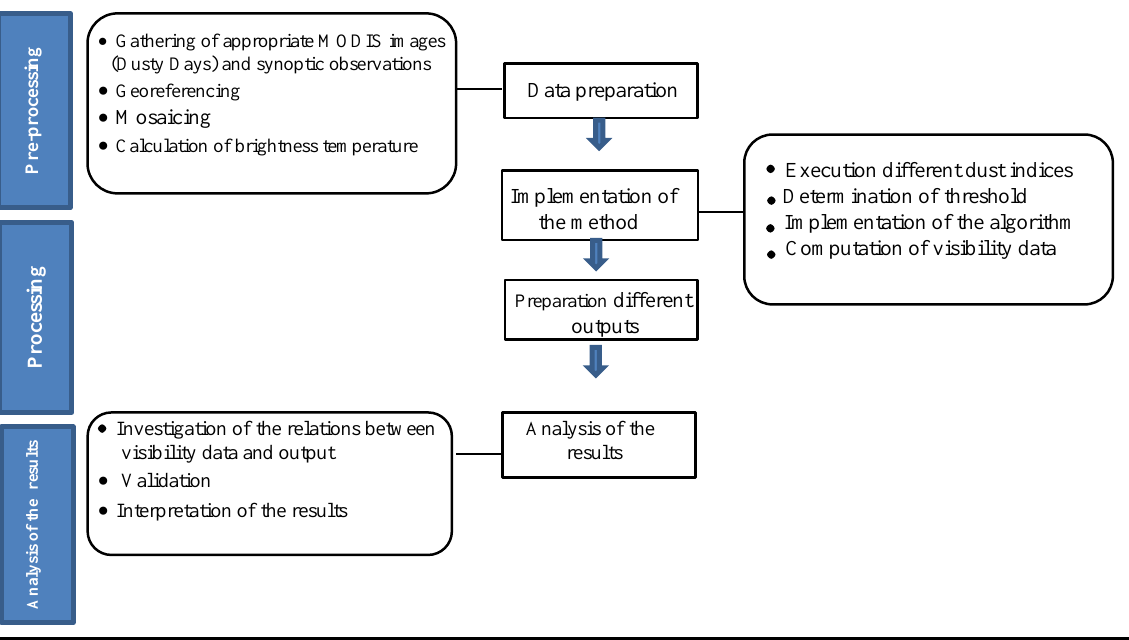
Figure 3. The flow chart of the study